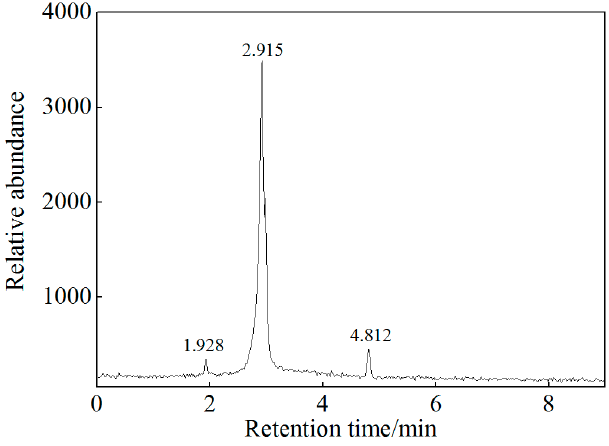
Figure 5. Chromatogram of oxidation products of TCP.